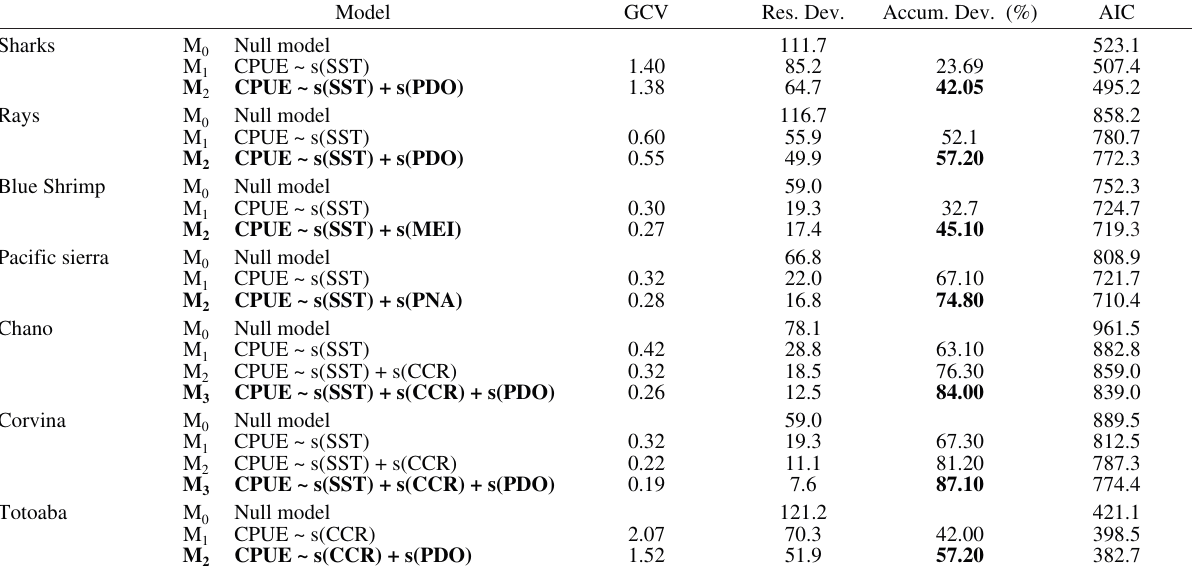
Table 1. – Generalized additive models resulting from the evaluation of the effect of environmental variables on changes in relative stock abundance for a variety of species in the NGC. GCV represents the generalized cross validation index; Res. Dev. the residual deviance; Ac- cum. Dev. the accumulated explained deviance, in percentage; and AIC the Akaike information criterion. The best fits of the model are shown in